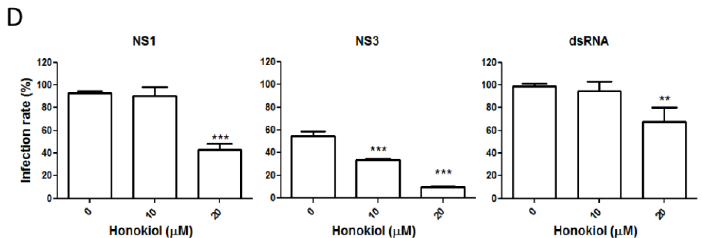
Figure 3. Honokiol inhibits dengue virus translation and replication in cells. ( A ) Immunofluorescence assay of honokiol-treated, DENV-infected BHK cells with MOI = 0.1. The viral NS1, NS3, and dsRNA antigens were detected after 48 h of honokiol treatment; ( B ) Immunofluorescence assay of honokiol-treated, DENV-infected Huh7 cells with MOI = 10. The viral NS1, NS3, and dsRNA antigens were detected after 48 h of honokiol treatment; ( C , D ) The percentage of viral NS1, NS3, and dsRNA positive cells was analyzed using the BD Pathway TM 435 Bioimaging system in ( C ) BHK and ( D ) Huh7, respectively. (Graph is plotted through calculating the percentage of NS1, NS3, and dsRNA expression in each image.) Data indicate the average value of triplicates (mean ± SD). ** p = 0.01; *** p < 0.001, as compared with the control.